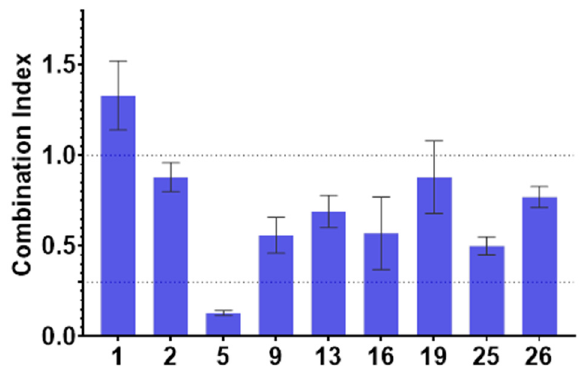
Figure 1. Interaction of compound 1 and derivatives 2 , 5 , 9 , 13 , 16 , 19 , 25 , and 26 with doxorubicin in drug combination assay on resistant Colo 320 adenocarcinoma cells. Combination index (CI) values are expressed as the mean of three CI values determined on different drug ratios and standard deviation (SD) for an inhibitory concentration of 50% (IC 50 .). 0.1 < CI < 0.3: strong synergism; 0.3 < CI < 0.7: synergism; 0.7 < CI < 0.9: moderate to slight synergism; 0.9 < CI < 1.1: nearly additive;